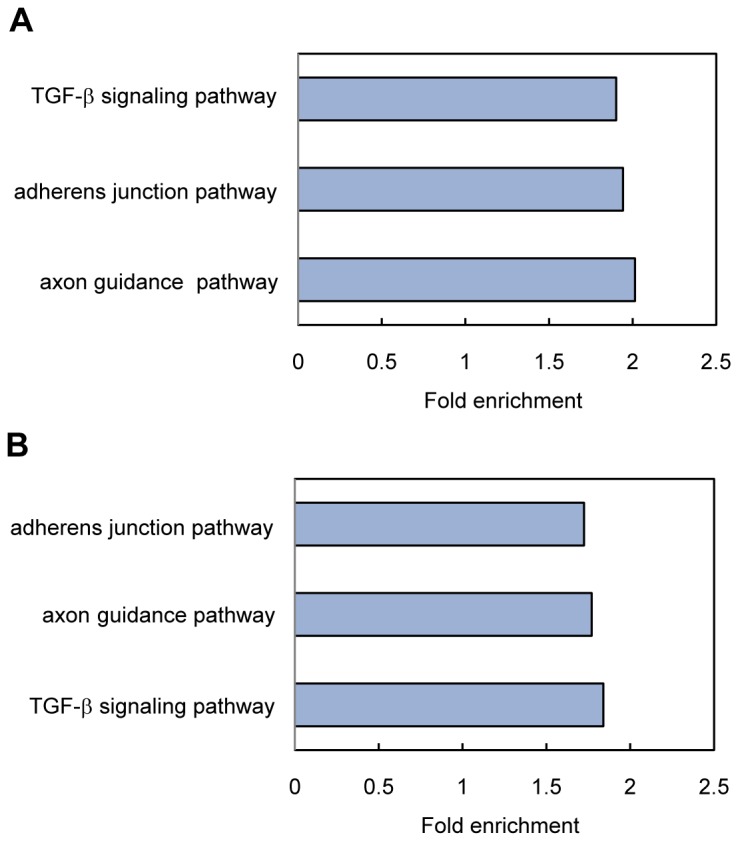
KEGG pathway analysis of the predicted targets of differentially expressed microRNAs.(A) The top three significantly enriched pathways in influenza virus BJ501 infection. (B) The top three significantly enriched pathways in influenza virus PR8 infection.